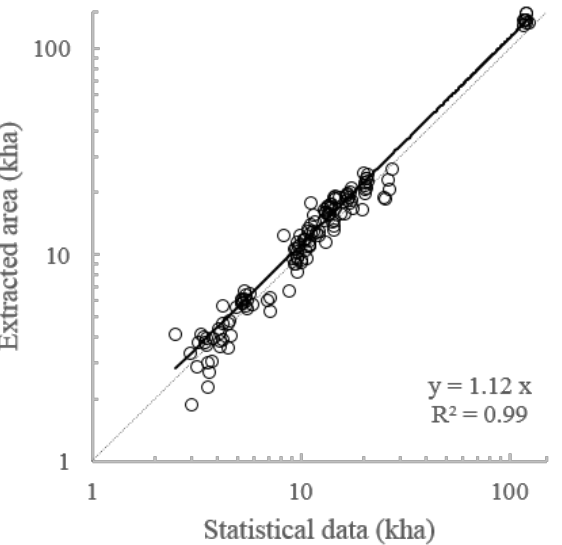
Figure 6. The county-level extracted sugarcane planting area against statistical data.